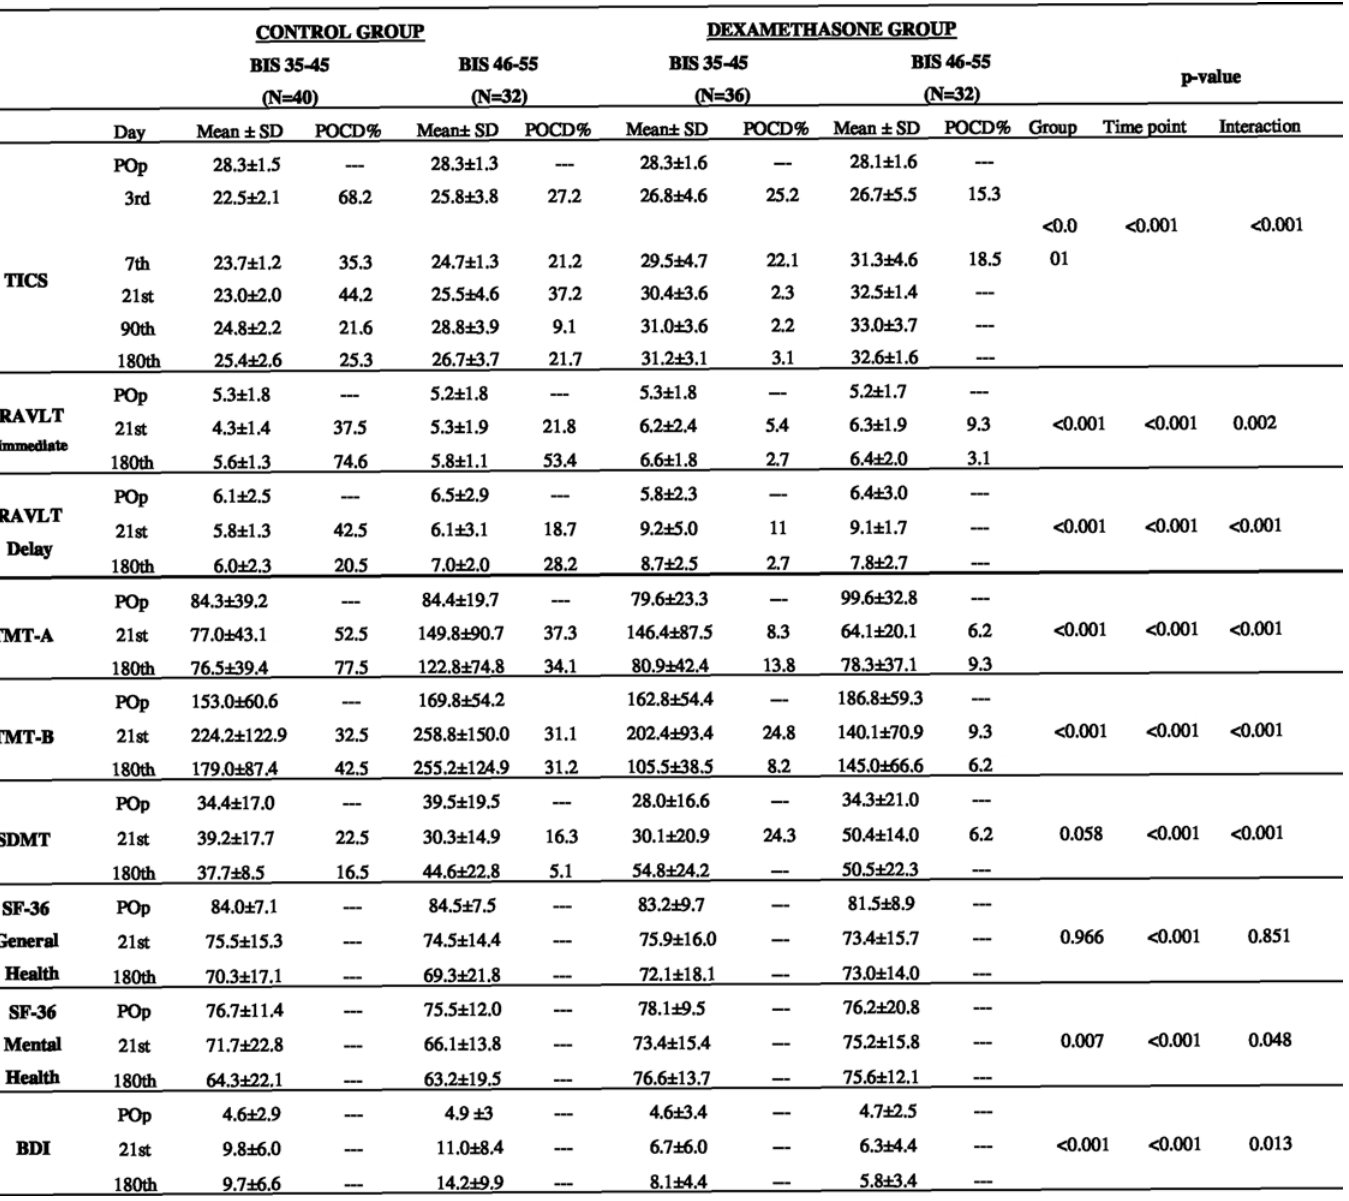
PLOS ONE | DOI:10.1371/journal.pone.0152308 May 6,